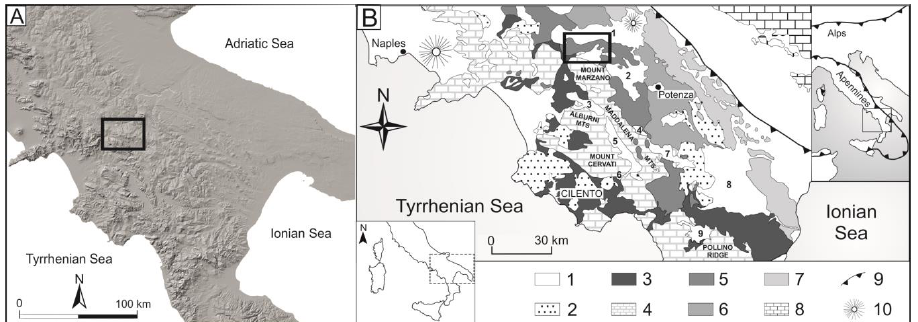
Figure 1. ( A ) Location of the study area in the frame of the southern Italian landscape. ( B ) Geological sketch map of the southern Apennines. The study area is represented in the box. Legend: (1) Pliocene to Quaternary clastic deposits and volcanic products; (2) Miocene syntectonic deposits; (3) Cretaceous to Oligocene ophiolite-bearing internal units; (4) Mesozoic–Cenozoic shallow-water carbonates of the Apennines platform; (5) lower–middle Triassic to Miocene shallow-water and deep-sea successions of the Lagonegro-typeMonte Arioso unit; (6)Mesozoic to Miocene deep-sea successions of the Lagonegro-type Groppa d’Anzi unit; (7) Cretaceous to Miocene deep-sea successions of the Lagonegro-type Campomaggiore unit; (8) Mesozoic–Cenozoic shallow-water carbonates of the Apulian platform; (9) thrust front of the chain; (10)